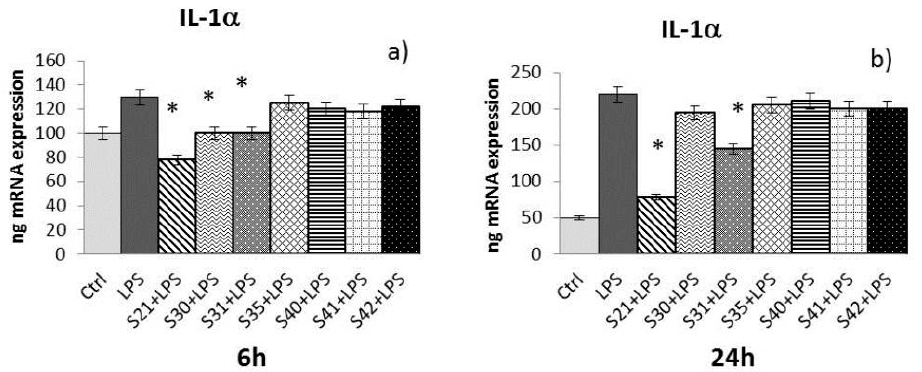
Figure 6. mRNA expression of IL-1 α from HaCat cells treated with S21, S30 , S31, S35, S40, S41 and S42 non-woven tissue bio-composites (10 µ g/mL) plus P. aeruginosa lipopolysaccharide (LPS) (10 µ g/mL) 6 h ( a ) and 24 h ( b ). Data are mean ± SD of values calculated on two different experiments. * P < 0.05 compared to LPS (10 µ g/mL) alone.